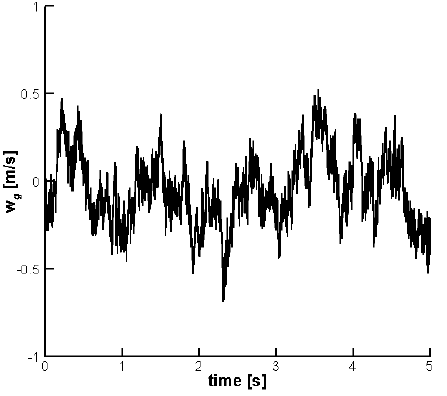
Figure 12. Time history of random atmospheric turbulence with PSD equal to von Kármán spectrum ( h = 200 m, intensity: 10 − 3 “moderate”, U ∞ = 8 m/s and maximum instantaneous intensity of 0.8 m/s).